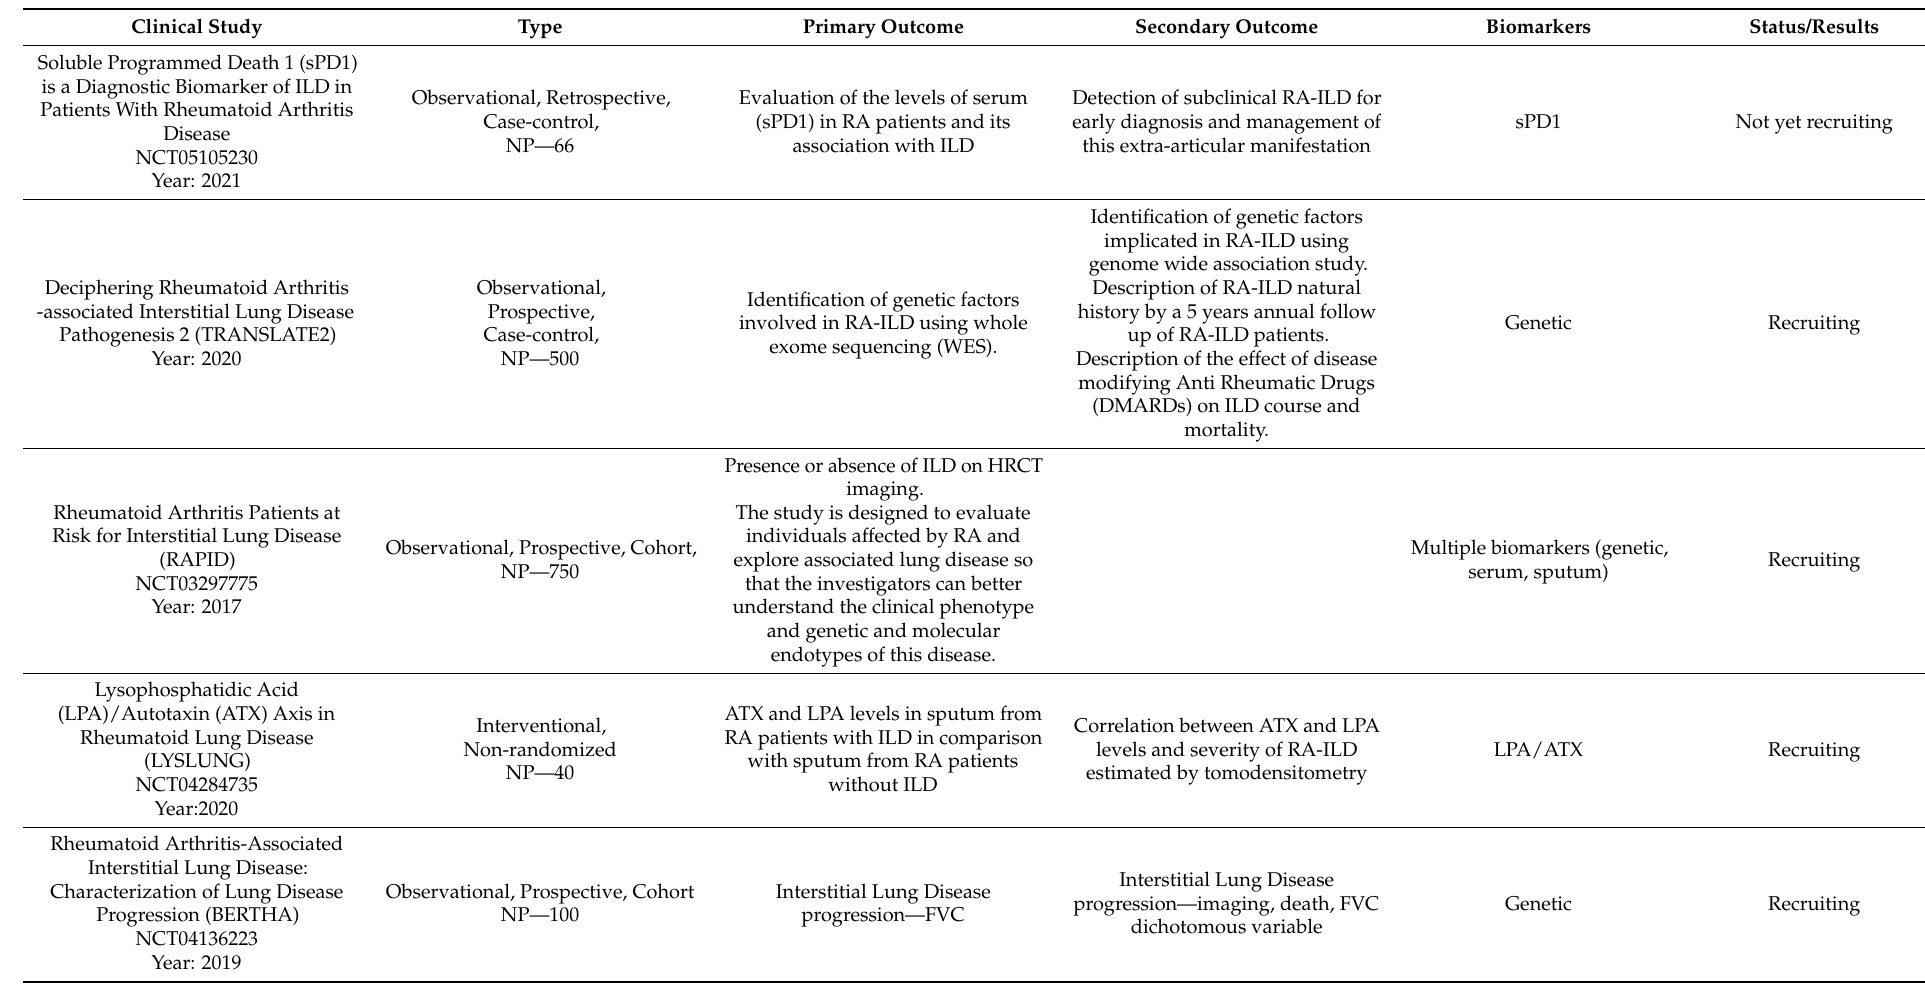
Table 2. Clinical study in RA-ILD